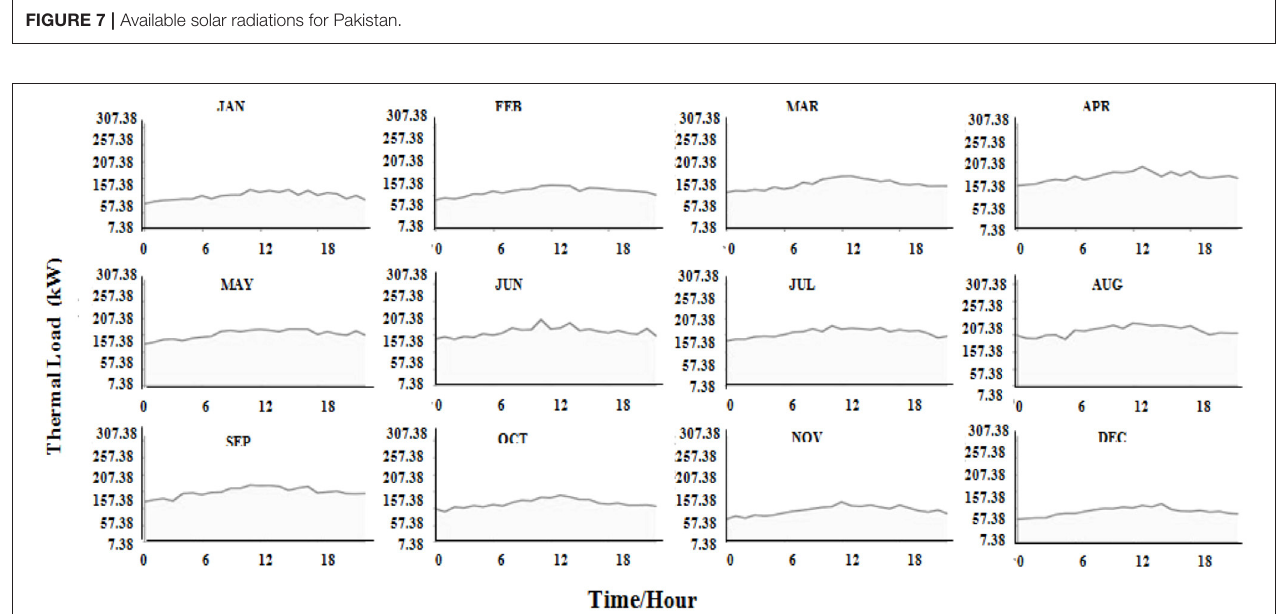
FIGURE 8 | Thermal load profile of 53 ton hospital in Taxila,